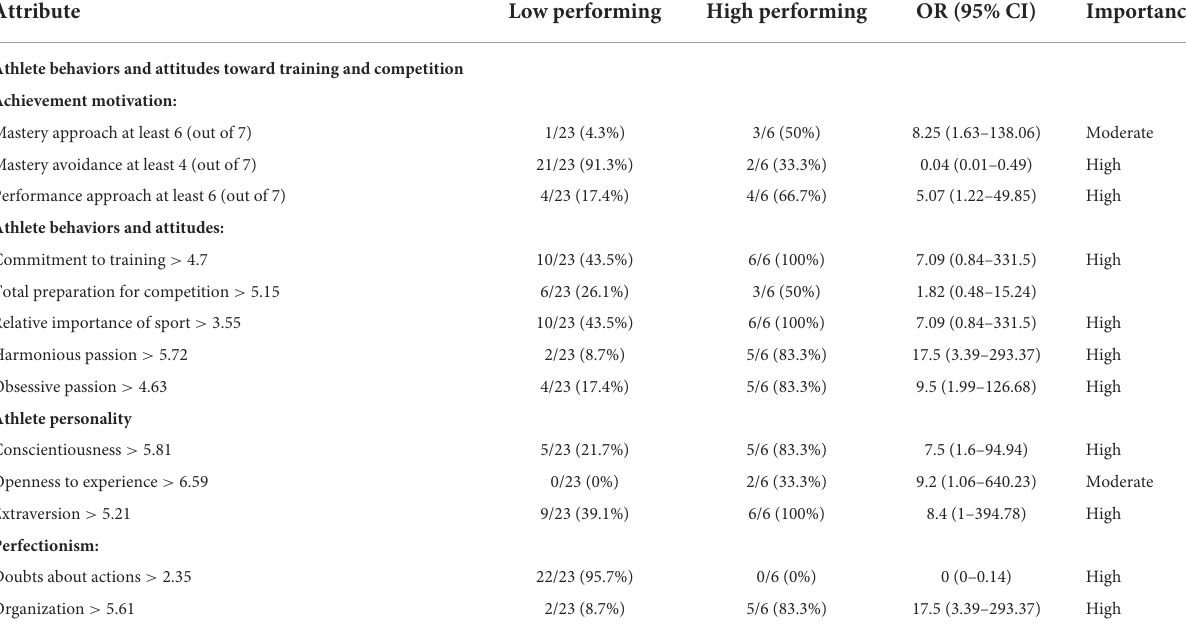
TABLE 6 Logical attributes for all discriminative features within psychosocial